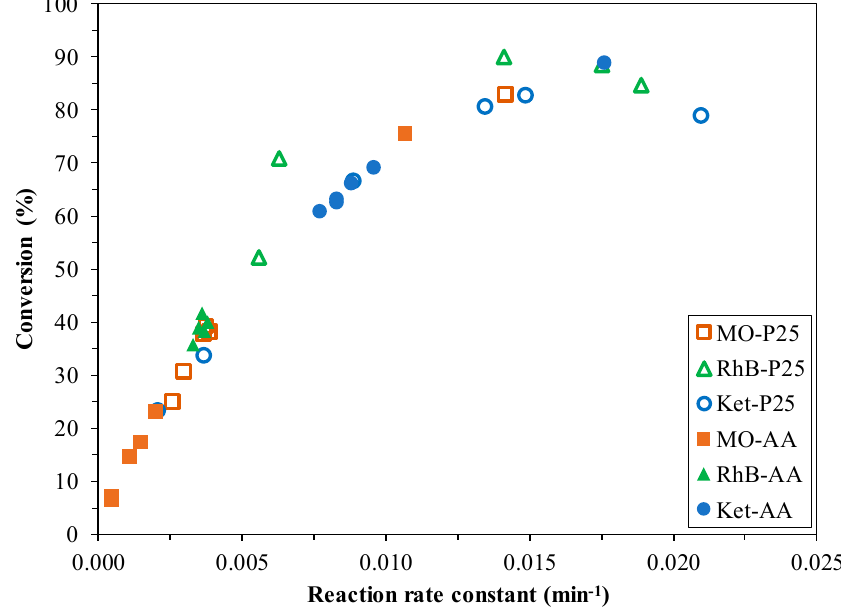
Figure 8. The evolution of the photocatalytic conversion of the studied organic pollutants in function of the reaction rate constant.